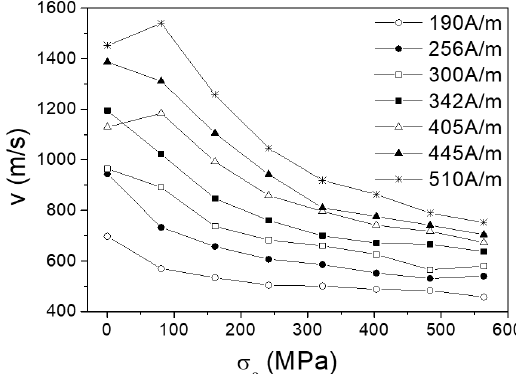
Figure 6. Tension stress dependences of domain wall (DW) velocity in microwires № 2. Reprinted with permission from [6].